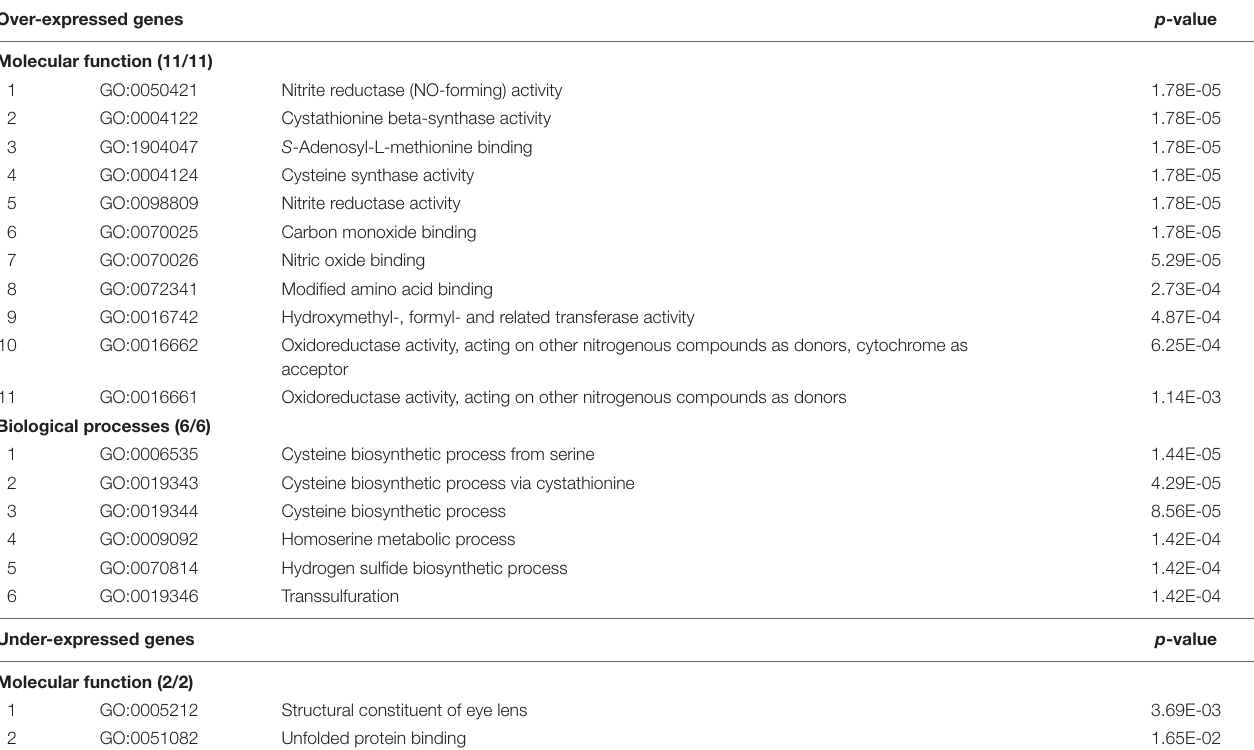
The gene expression ratios observed by Real-Time RT- PCR between DS and normal conditions and mean features obtained from in vitro and in silico analyses, for each target gene, are shown numerically in Table 4 and graphically in Figure 3 . The correlation between the observed and expected gene expression ratios, performed by bivariate analysis using JMP 5.1 program, is statistically highly significant (Pearson correlation coefficient = 0.93 and p -value < 0.0001) ( Figure 3